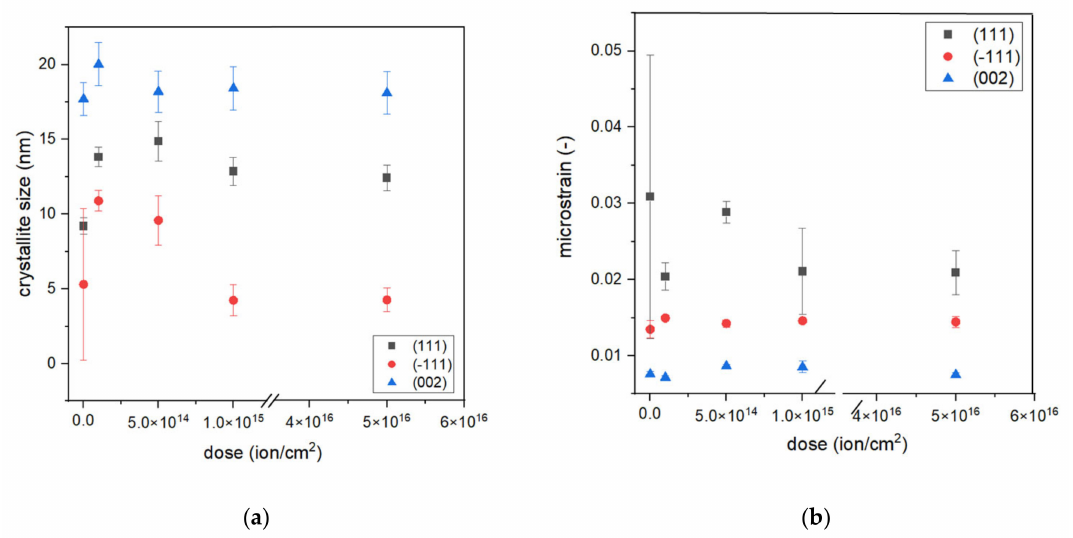
Figure 4. The dependence of ( a ) crystallite size and ( b ) microstrain on dose of implantation. The crystallite size depends on their orientation. We observed that ( − 111) oriented crystallites (average size of around 7 nm) were smaller than (111) and (200) oriented crystallites, with an average size of 12 nm and 18 nm, respectively. The microstrain exhibits a different trend, the ( − 111) oriented crystallites demonstrate a larger strain than